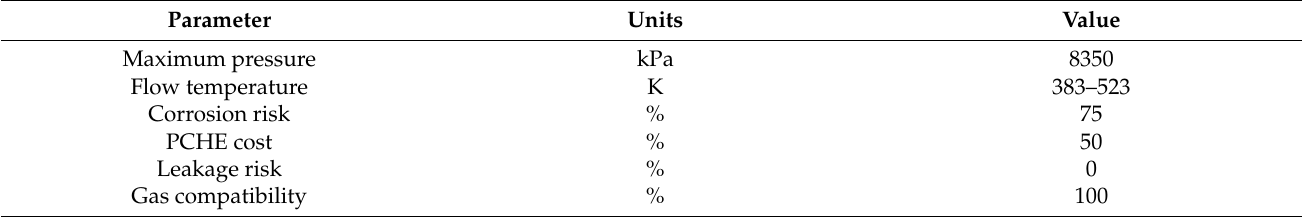
Table 5. Experimental and numerical results of PCHE